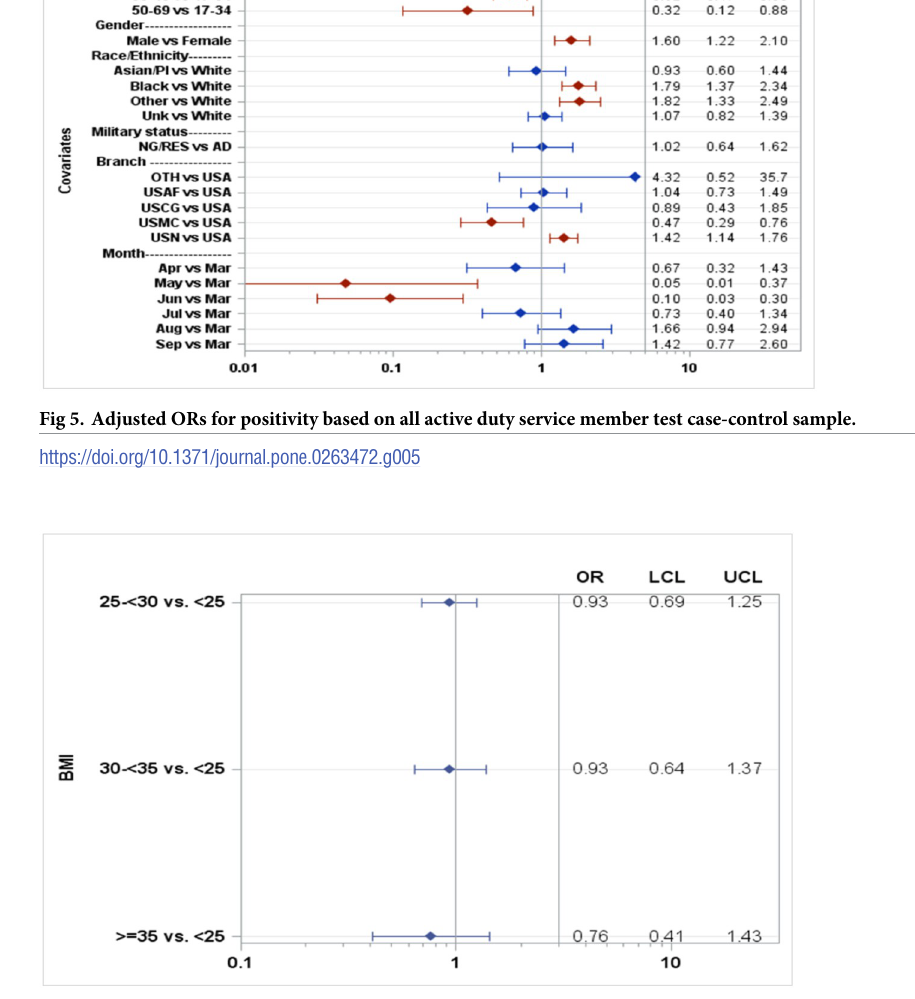
Fig 6. Unadjusted BMI ORs for positivity based on case-control